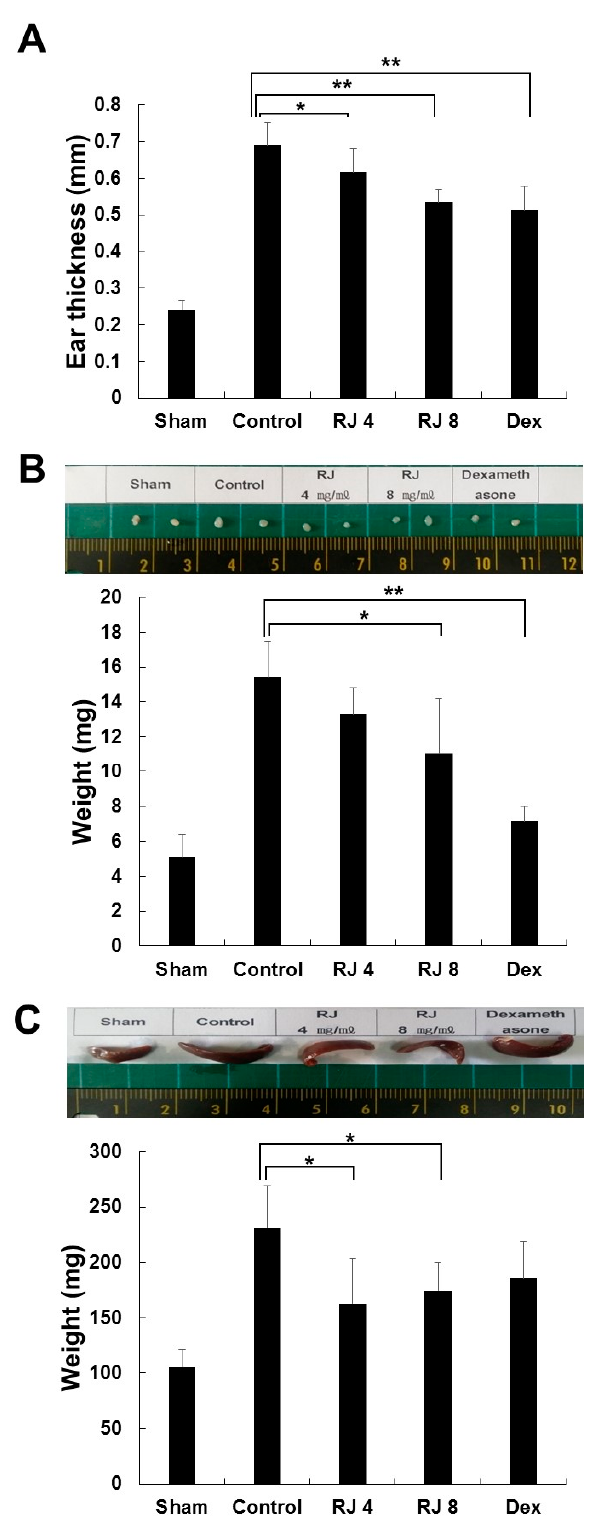
Figure 4. Inhibitory effects of RJ on DNCB-induced AD skin symptoms in Balb/c mice. The mice were divided into five groups: Vehicle (Sham), DNCB + vehicle (Control), DNCB + RJ 4 mg/mL (RJ 4), DNCB + RJ 8 mg/mL (RJ 8), positive control (DEX). ( A ) Ear thickness was measured with a micrometer. Five mice were used per group. ( B , C ) Organ sizes were compared by photographic images. Organ and whole-body weight of five mice per group were measured. Five mice were used per group. The data shown are the mean ± SD of three independent experiments. Significant difference from control group, * p < 0.05, ** p < 0.01.